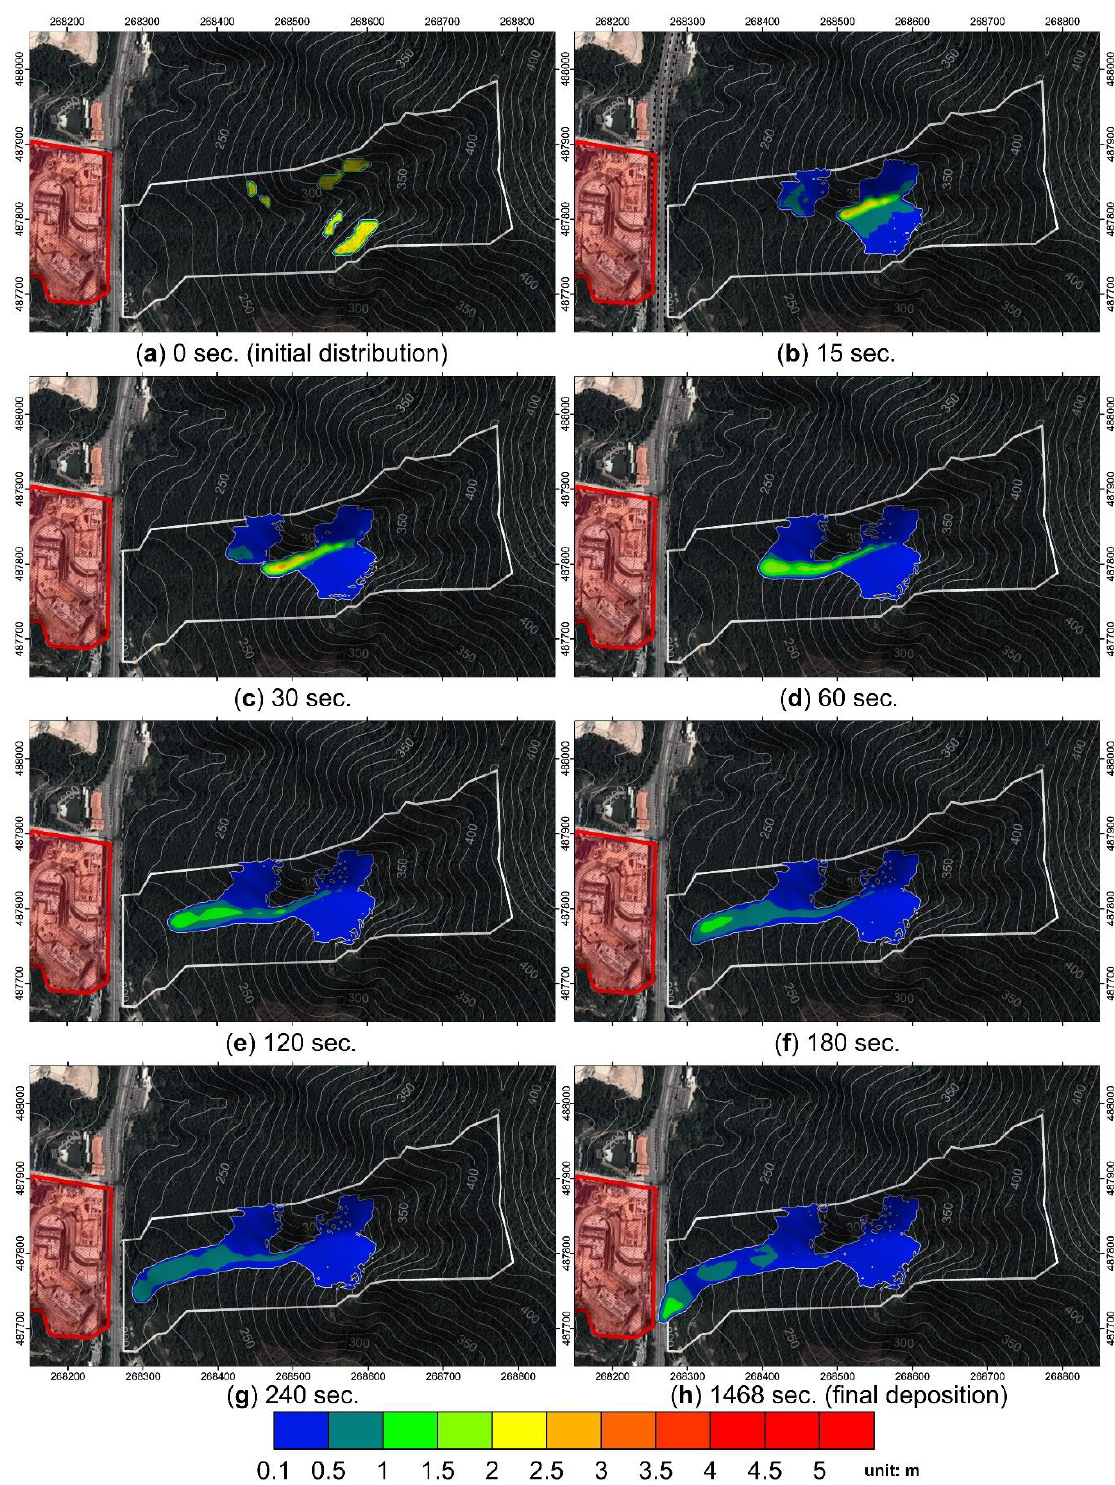
Figure 13. Simulated flow and thickness of debris at different times (( a )~( h )) in Watershed C.